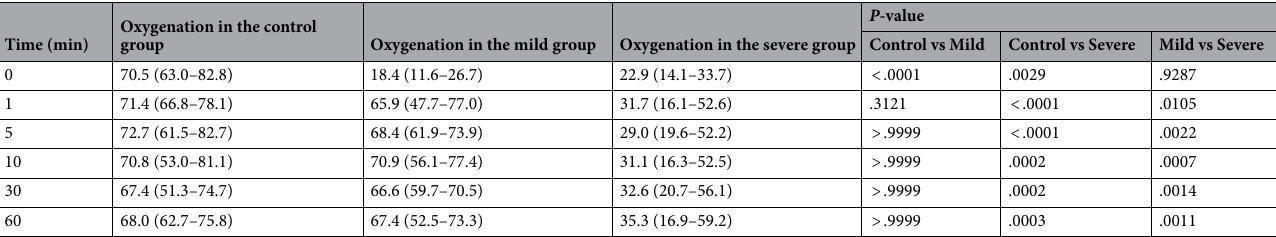
Table 1. Oxygenation after reperfusion in the control, mild, and severe groups. Note: Oxygenation of the mild and severe groups before and after removing the vascular clamps and the control group are shown. The time course of oxygenation after 1 min of reperfusion was clearly different between the mild and severe groups. Oxygenation was significantly higher in the mild group than in the severe group at 1, 5, 10, 30, and 60 min and did not show a significant difference with the control group. All values are shown as median (min–max). The Kruskal–Wallis test was used for evaluation.